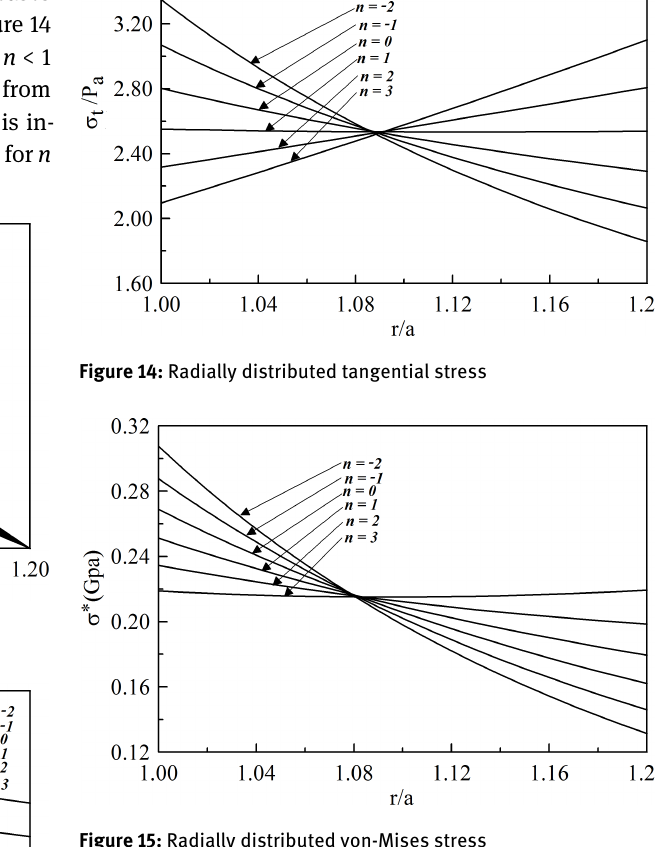
= 1 shows that tangential stress is uniform along the radial direction. Stress distribution along the radial direction